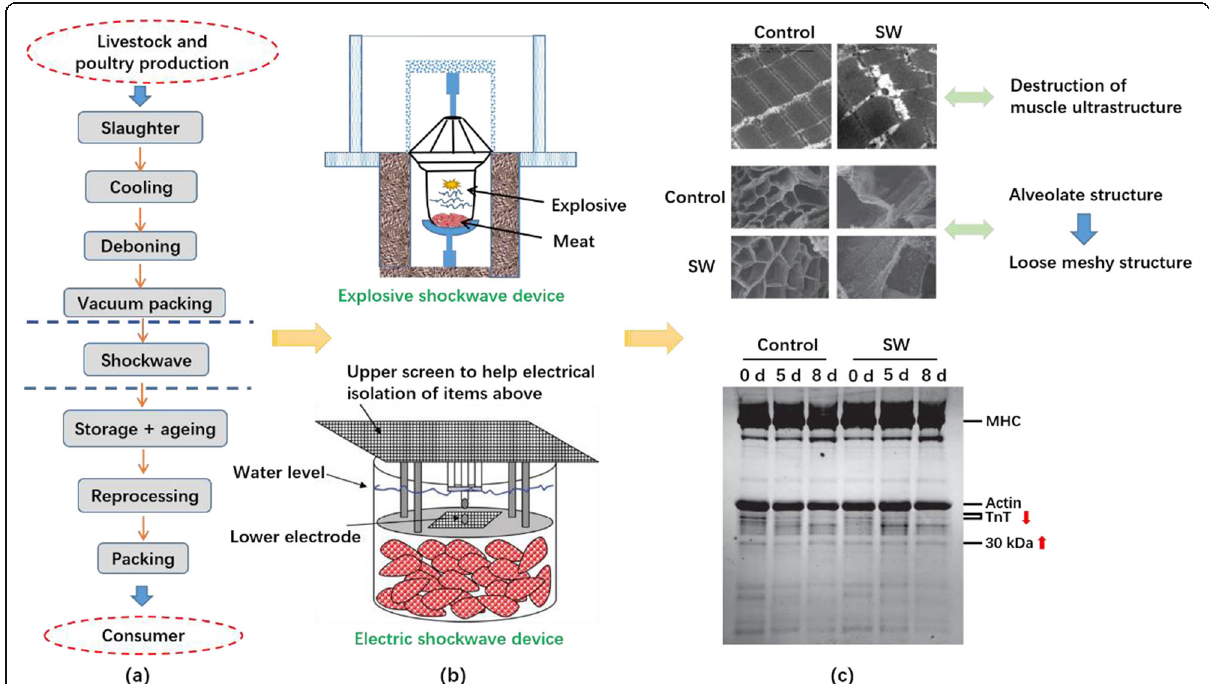
Fig. 6 Schematic representation of tenderising meat by shockwave. a Application of shockwave in the production process. b Two different shockwave devices. c Tenderising mechanisms include tissue destruction, changes in protein morphology and structure, and enhanced postmortem proteolysis (Bowker et al. 2008; Zuckerman et al.